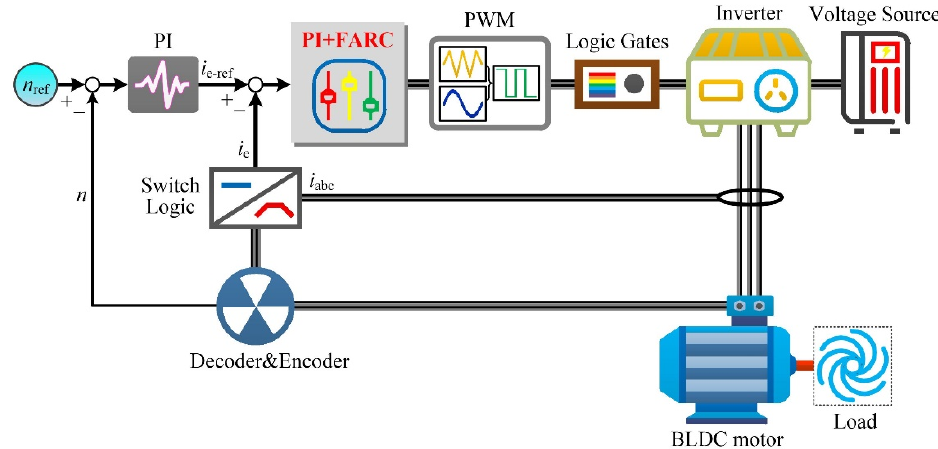
Figure 1. Schematic diagram of the BLDC motor control system used novel current loop controller.